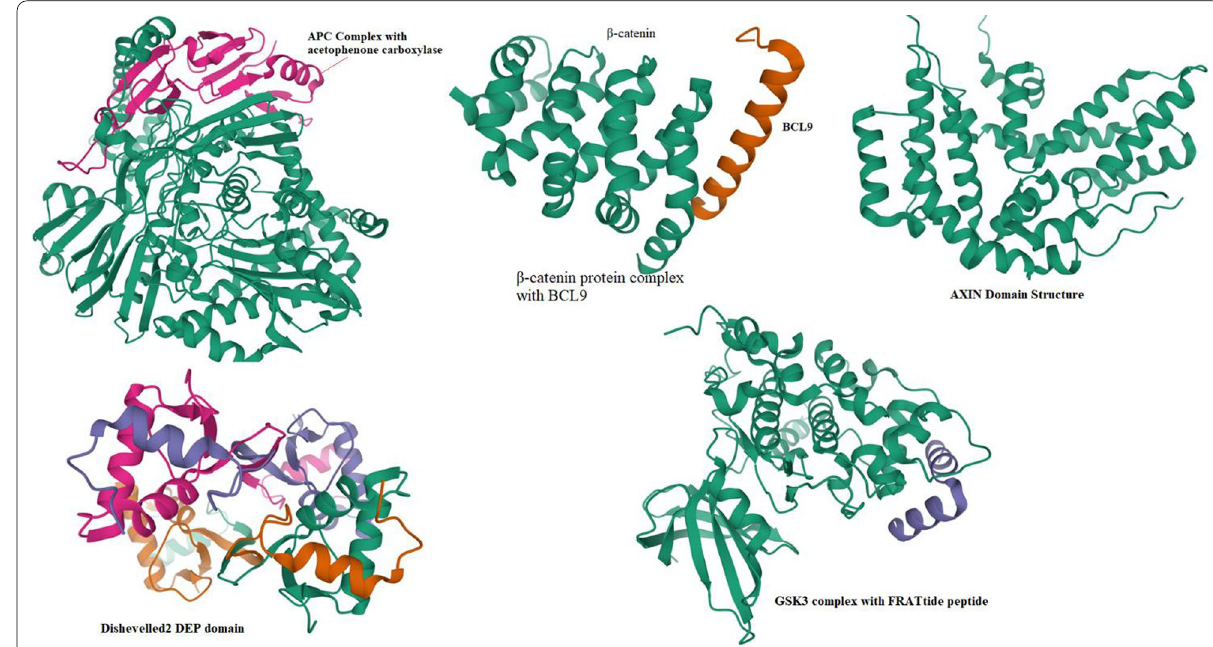
Fig. 2 Representation of Homology model of WNT signaling proteins predicted using Swiss Model